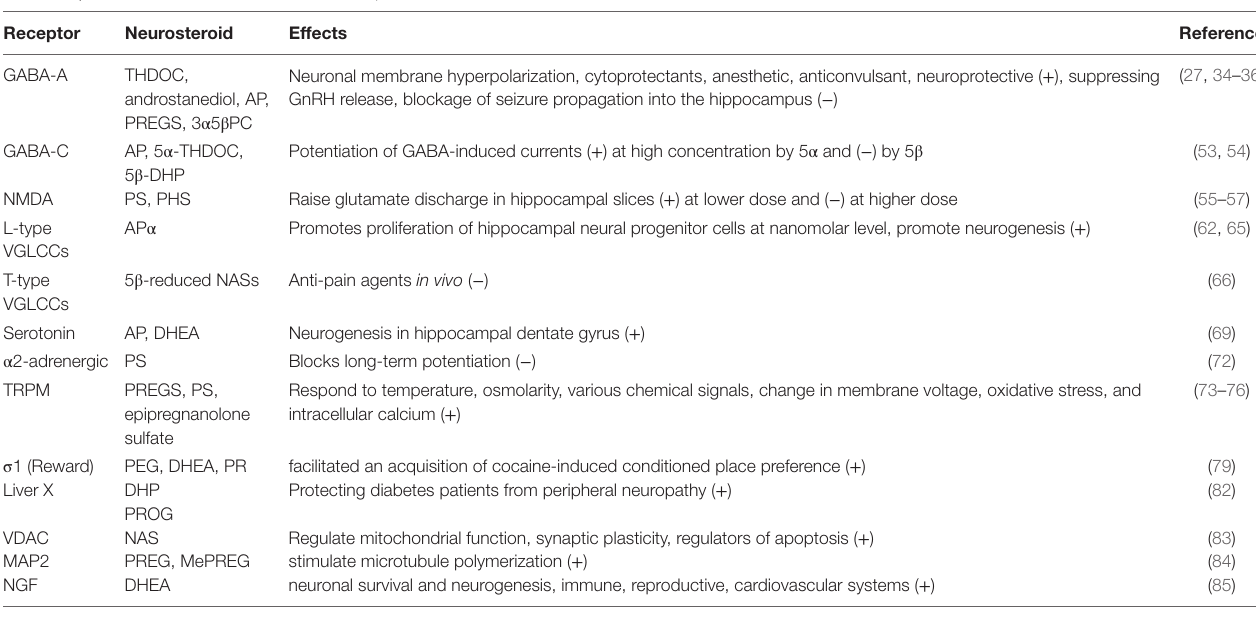
TABLe 1 | Effect of neurosteroids on various